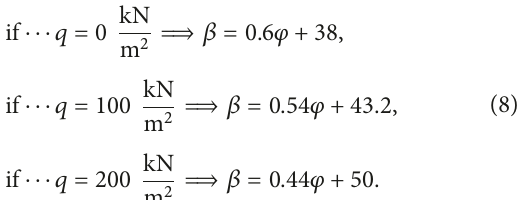
Figure 5: Changes in active pressure coefficient ( 𝐾 changes in the distance of surcharge from wall for different amounts of the angle of internal soil friction.